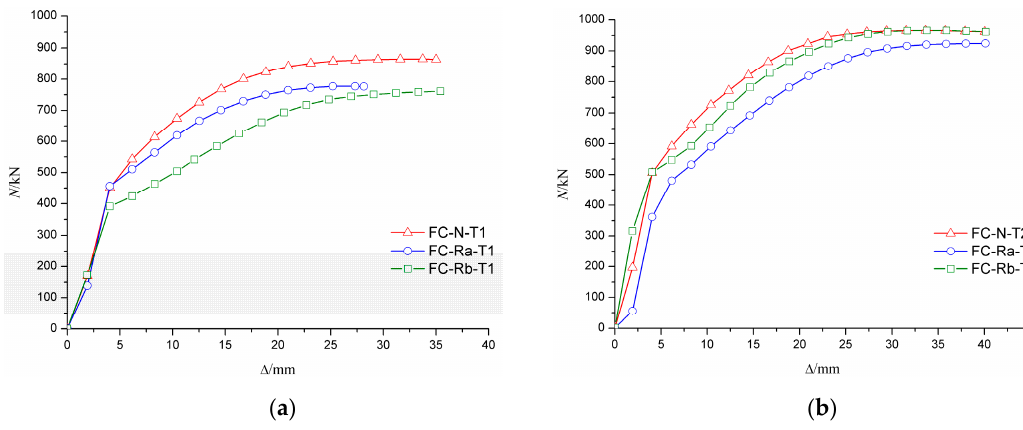
Figure 21. Influence of concrete material on N- ∆ curve. ( a ) The wall thickness of steel tube is 4 mm; ( b ) The wall thickness of steel tube is 5 mm.